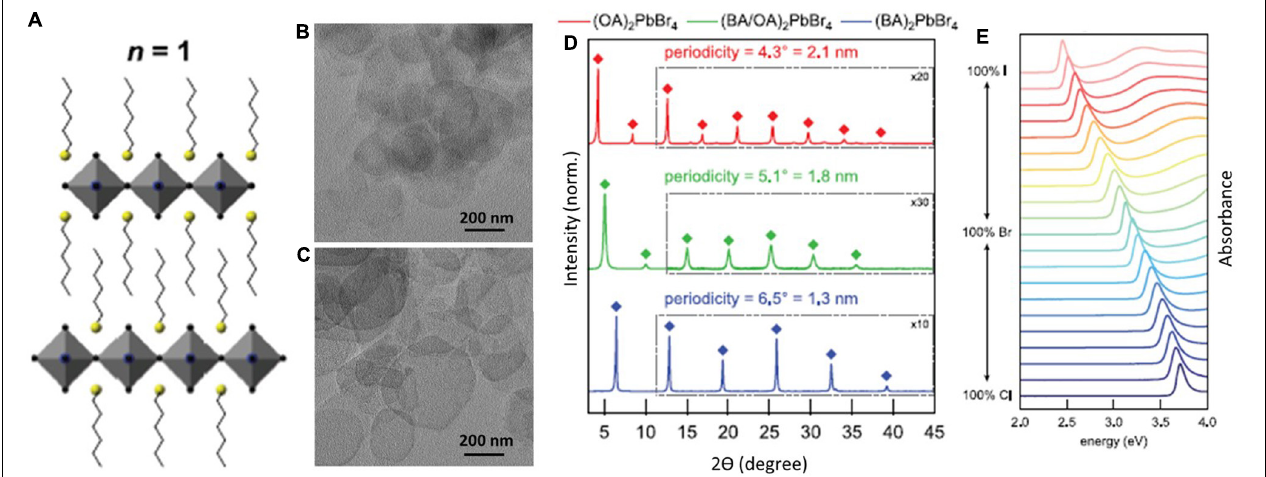
FIGURE 1 | (A) Schematic presentation of L 2 PbX 4 , where two successive corner-shared [PbX 6 ] 4 − are separated by two flipped organic ammonium ions. (B,C) TEM images of L 2 PbCl 4 and L 2 PbBr 4 , respectively. (D) Powder x-ray diffraction patterns of (OA) 2 PbBr 4 (red), (OA/BA) 2 PbBr 4 (green), and (BA) 2 PbBr 4 (blue) layered perovskites. Here, OA and BA stand for octylammonium and butylammonium, respectively. (E) Absorption spectra of L 2 PbX 4 showing continuous tunability with